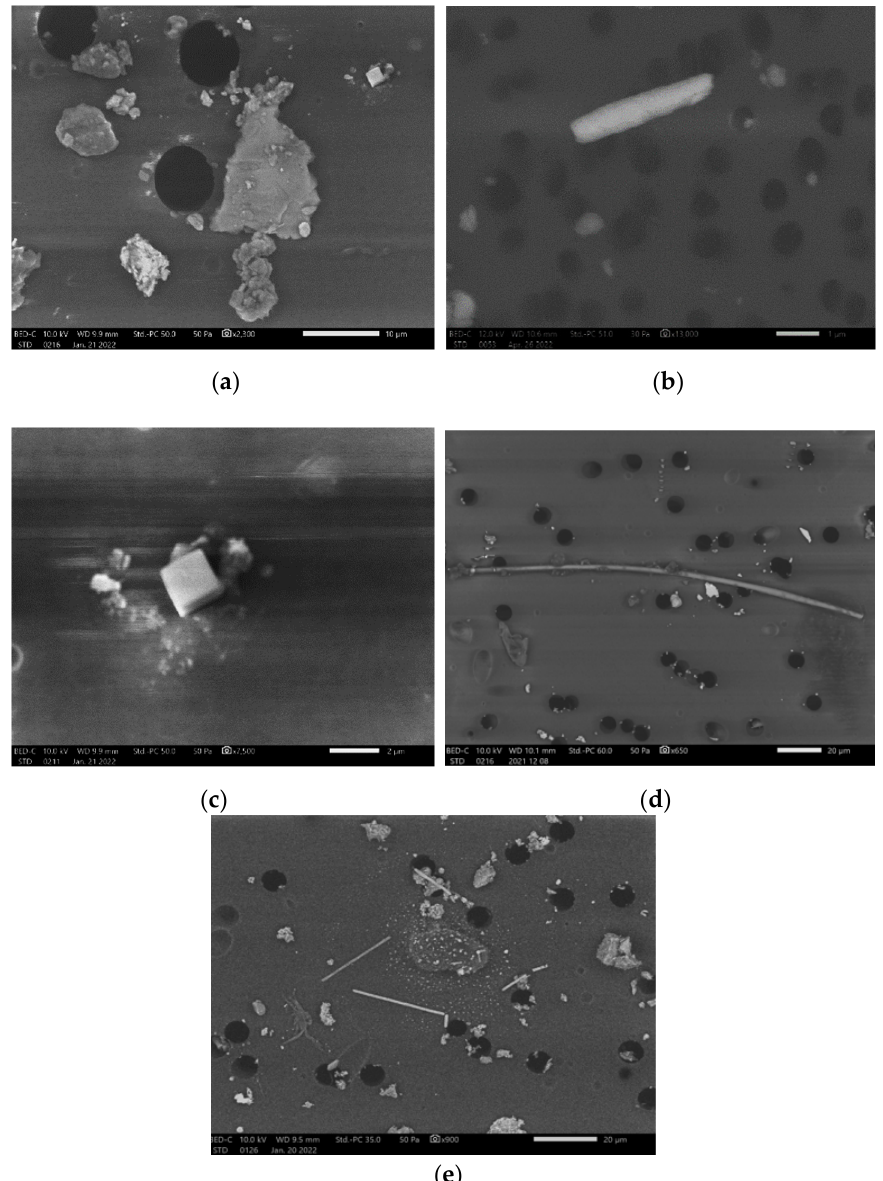
Figure 4. The determined particle types by scanning electron microscopy: ( a ) Al-, Si-, K- and Mg-rich amorphous particles (old tram, 2012); ( b ) Fe-rich filings (Metro, 2014); ( c ) cubic NaCl particle (old tram, 2012); ( d ) fibrous C–O-rich particle (IC train, 2014); ( e ) K-rich fibers (old tram, 2014).